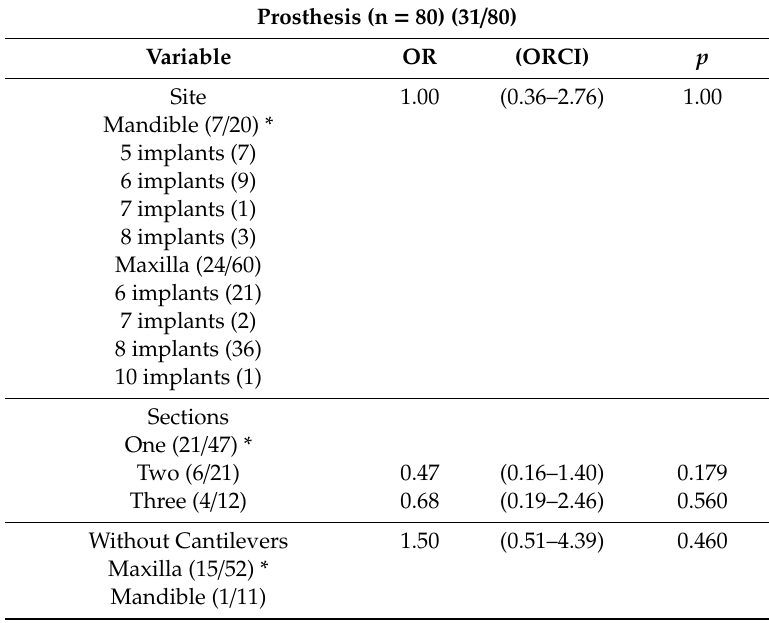
Table 8. Distribution of mechanical technical complications in the sample in relation to prosthesis based